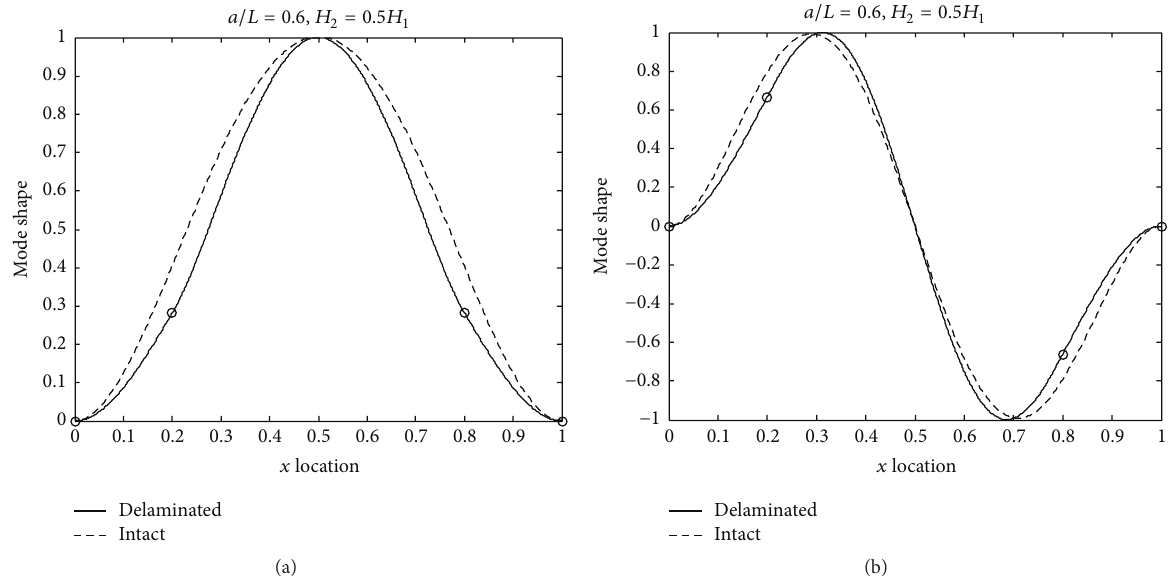
Figure 5: The first two natural modes for a 2-layered beam with centrally located, 60% midplane delamination, compared with those of the intact configuration; (a) 1st modes. (b) 2nd modes.